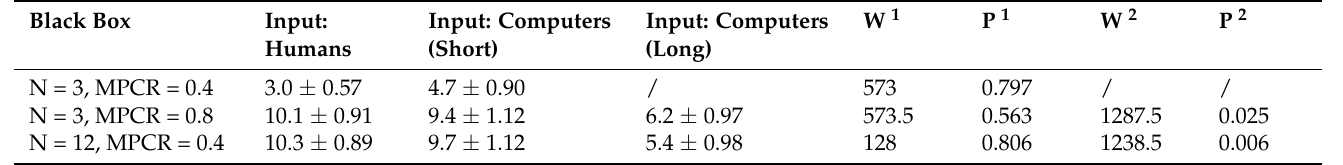
Table 2. Final contributions. Comparison of mean final round contributions (“inputs”) of virtual coins into the black box (0–20 coins). Comparisons made with Wilcoxon rank-sum test.